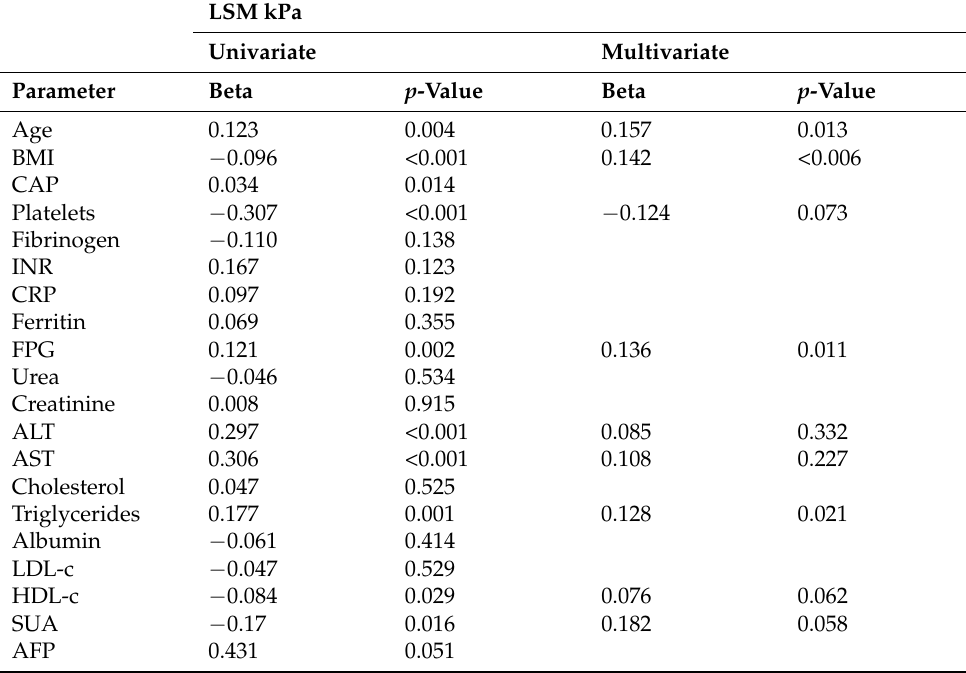
Table 3. Univariate and multivariate linear regression analysis of factors associated with increased LSM values. LSM kPa Univariate